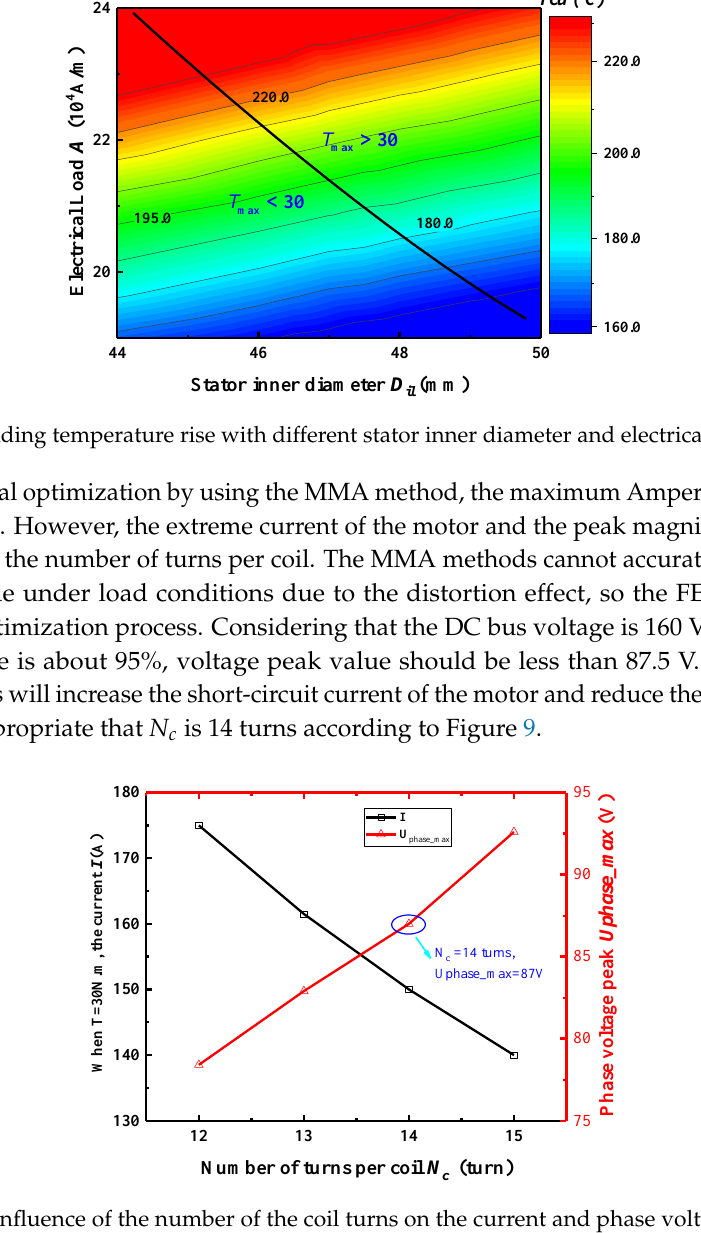
Figure 9. The influence of the number of the coil turns on the current and phase voltage peak when T = 30 N·m.